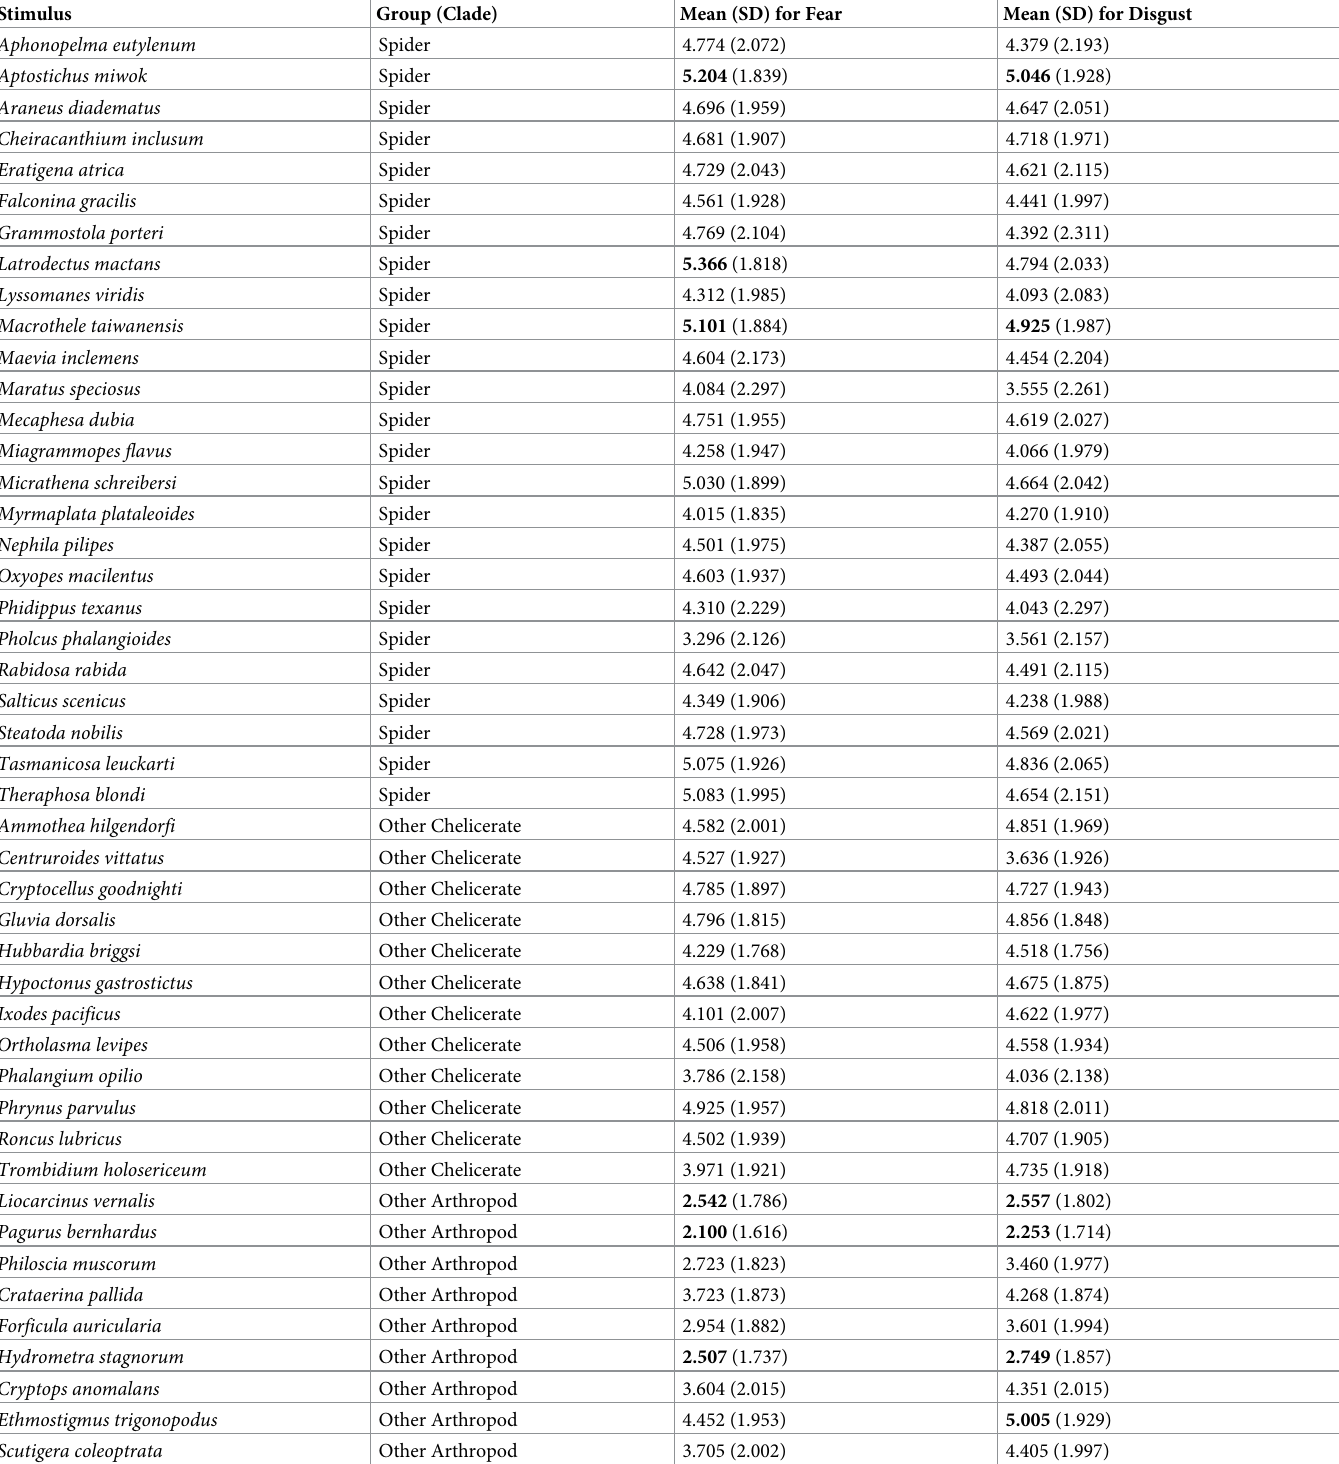
Table 1. Mean scores and their standard deviations (SD) for all stimuli as rated by all respondents (N =